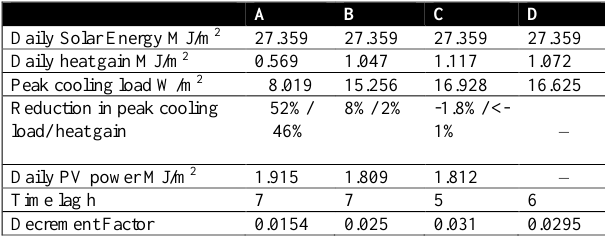
Simulation Results of thermal analysis for rooftop shaded by PV